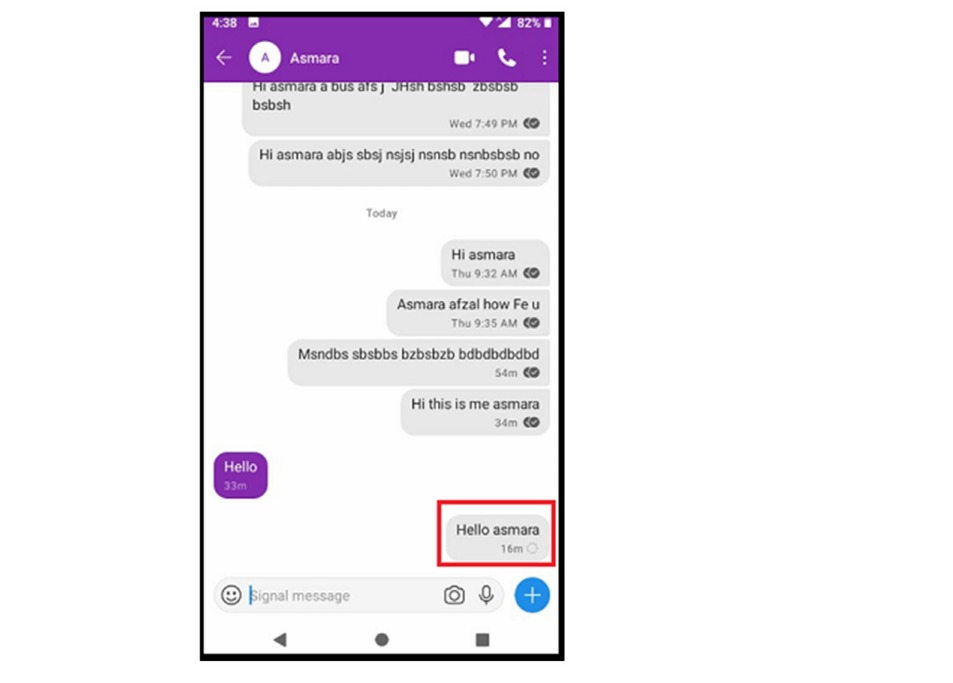
Figure 19. Screenshot of message sending failed.